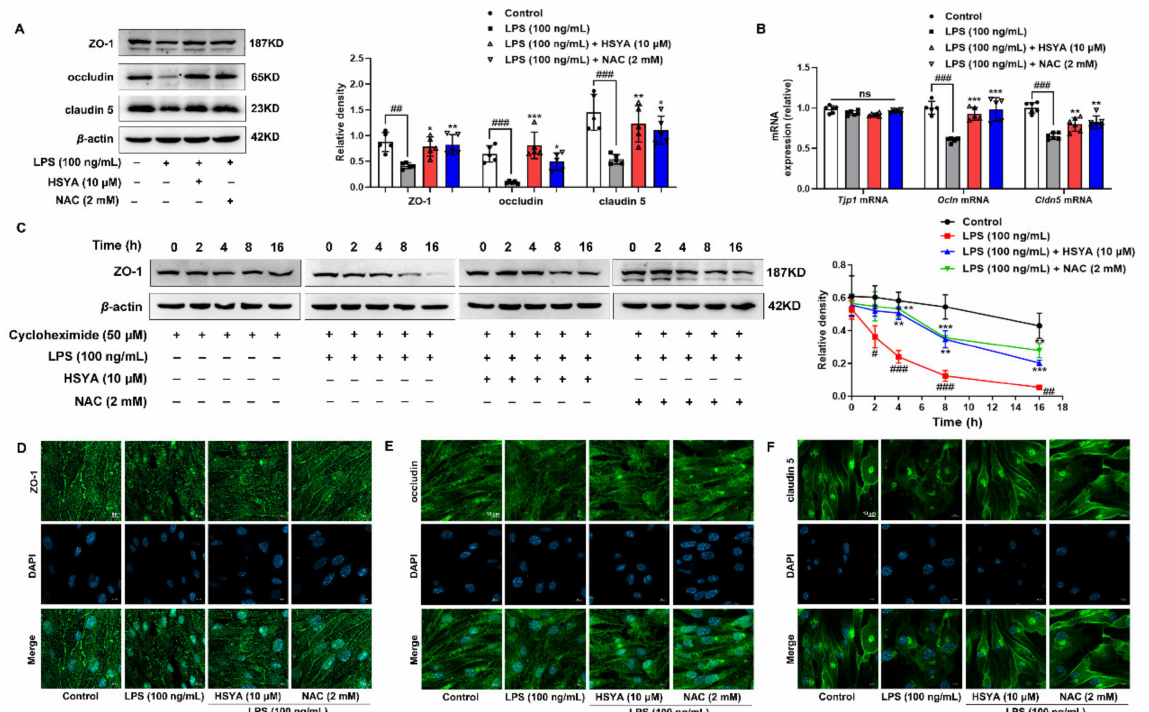
Figure 4. HSYA protected ZO-1 from oxidative damage: ( A ) protein expression of ZO-1, occludin, and claudin 5; ( B ) gene expression of ZO-1 ( Tjp1 ), occludin ( Ocln ), and claudin 5 ( Cldn 5 ); ( C ) ZO-1 protein degradation at the indicated time was determined when protein synthesis was inhibited by cycloheximide in LPS-stimulated bEnd.3 cells; ( D – F ) immunofluorescence showed the expression of ZO-1, occludin, and claudin 5 protein in bEnd.3 cells in the presence of LPS (scale bar: 10 µ m). All data are presented as mean ± SD of five independent experiments. # p < 0.05, ## p < 0.01, ### p < 0.001 vs. indicated group, * p < 0.05, ** p < 0.01, *** p < 0.001 vs. LPS group; ns: no significant